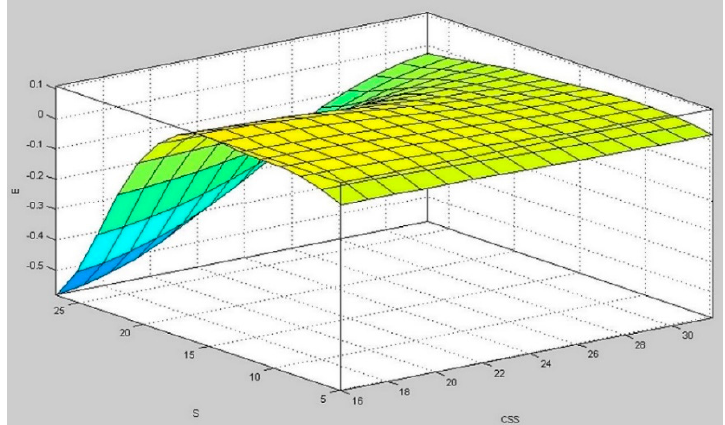
Figure 6. Energy (E) in relation to change of closed side set (CSS) and strength (S).